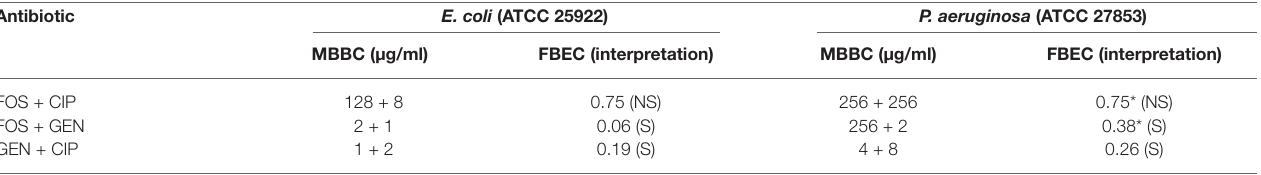
TABLE 2 | MBBC and FBEC values for fosfomycin (FOS), ciprofloxacin (CIP), and gentamicin (GEN) in combination against E. coli and P. aeruginosa . Antibiotic